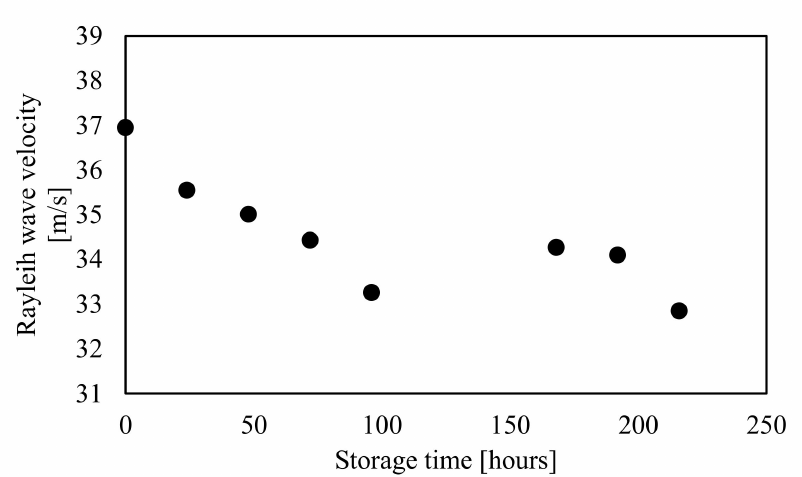
Figure 6. Relationship between the Rayleigh wave velocity and storage time of mango 6 (Measure- ment path: Line